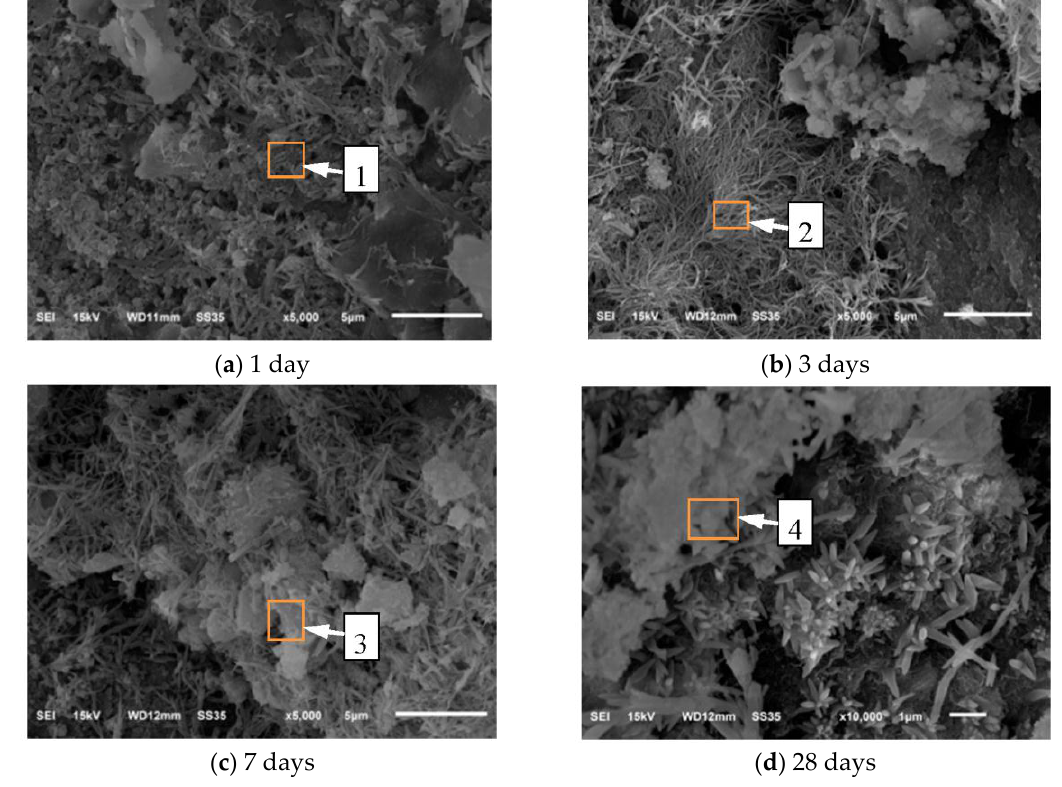
Figure 2. SEM images of microstructure of the products at different ages: ( a ) 1day; ( b ) 3 days; ( c ) 7 days; ( d ) 28 days. 1, 2, 3, 4 are the position numbers in Table 7. Table 7. Chemical element compositions of the products tested by energy dispersive spectrometer (EDS). Position Number